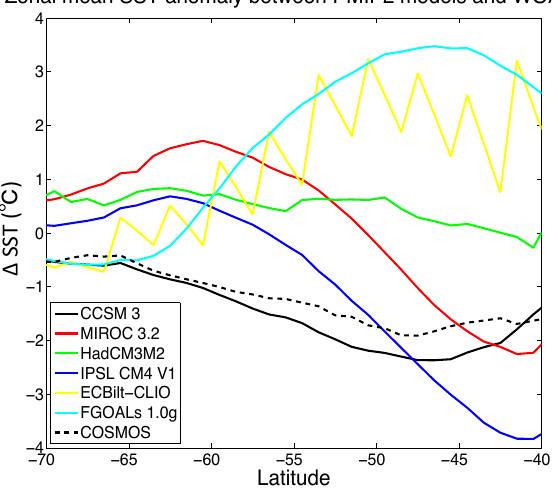
Fig. 10. Zonal mean of SST anomaly between respective PI control Figure 10 Zonal mean of SST anomaly between respective PI control runs of runs of the models participating in PMIP2 and observational data the models participating in PMIP2 and observational data (World Ocean (World Ocean Atlas 98), i.e. CCSM3 (black solid), MIROC 3.2 (red solid), HadCM3M2 (green solid), IPSL-CM4-V1-MR (blue solid), Atlas 98), i.e. CCSM3 (black solid), MIROC 3.2 (red solid), HadCM3M2 ECBilt-CLIO (yellow solid), FGOALS-1.0g (cyan solid)), as well (green solid), IPSL-CM4-V1-MR (blue solid), ECBilt-CLIO (yellow solid), as the model used in this study (COSMOS, black dashed). FGOALS-1.0g (cyan solid)), as well as the model used in this study (COSMOS, black dashed).